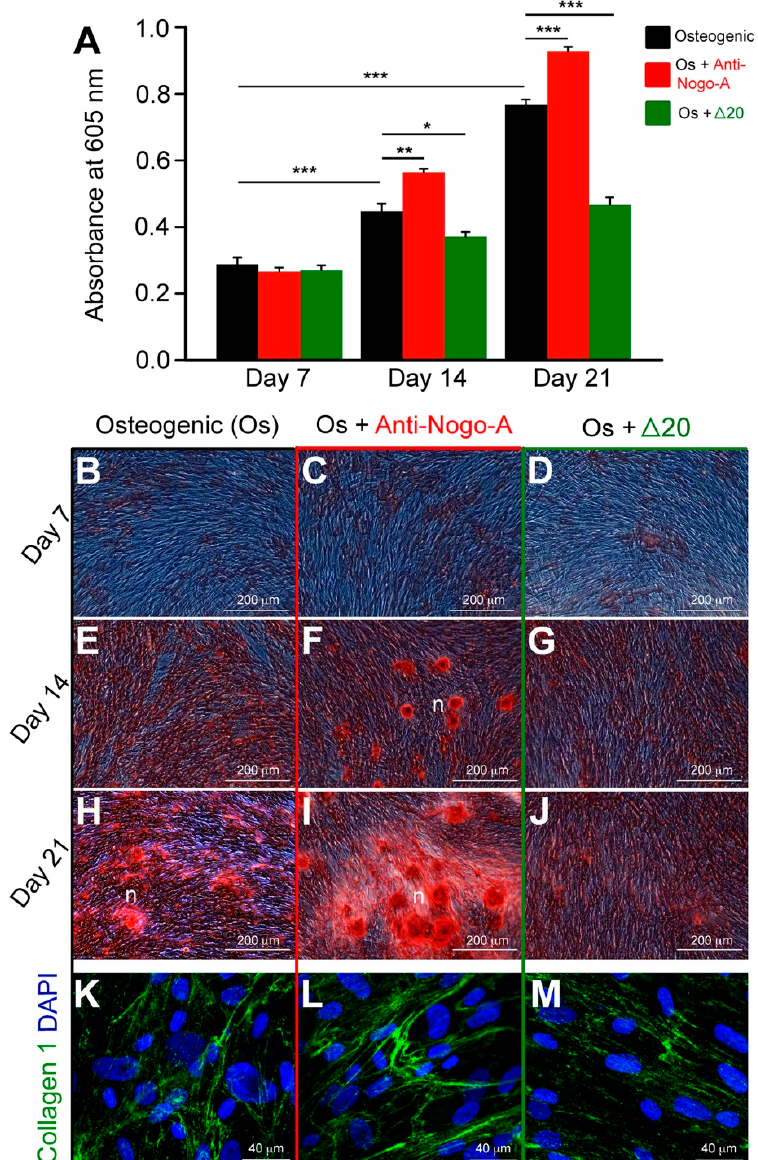
Figure 4. Effects of the Nogo-A protein (Nogo-A Δ 20 fragment) and anti-Nogo-A antibody on the osteogenic differentiation of hDPSCs. ( A ) Quantification of Alizarin Red S staining in hDPSCs cultured in osteogenic medium (Os) alone (black colored columns), in osteogenic medium supplemented with the anti-Nogo-A antibody (red colored columns), and in osteogenic medium supplemented with the Nogo-A Δ 20 protein (green colored columns) for 7, 14 and 21 days. Four independent biological replicates were used. The bars represent the means ± standard errors. Asterisks above the error bars denote significant differences (*, p < 0.05; **, p < 0.01; ***, p < 0.001) by one-way analysis of variance (ANOVA). ( B – J ) Alizarin Red S staining indicating the formation of mineralized nodules by hDPSCs cultured in the osteogenic medium alone ( B , E , H ), in osteogenic medium supplemented with the anti-Nogo-A antibody ( C , F , I ), and in osteogenic medium supplemented with the Nogo-A Δ 20 protein ( D , G , J ) for 7, 14 and 21 days. ( K – M ) Collagen type-I immunofluorescence staining (green color) in hDPSCs cultured for 21 days in the osteogenic medium alone ( K ), in osteogenic medium supplemented with the anti-Nogo-A antibody ( L ), and in osteogenic medium supplemented with the Nogo-A Δ 20 protein ( M ). DAPI (blue color) marks the cell nuclei. Abbreviation: n, mineralization nodules. Scale bars are as indicated.